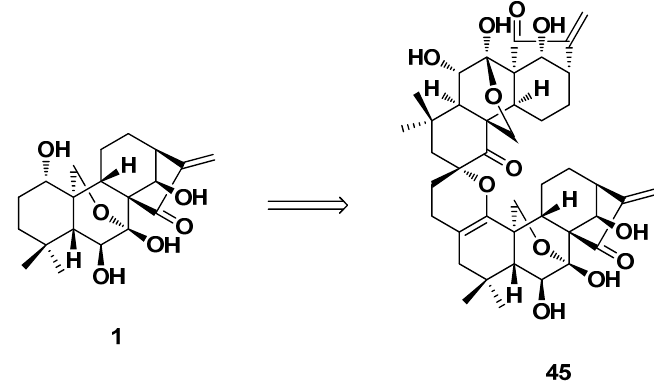
Figure 23. ent -Kaurane diterpenoid dimer 45 .